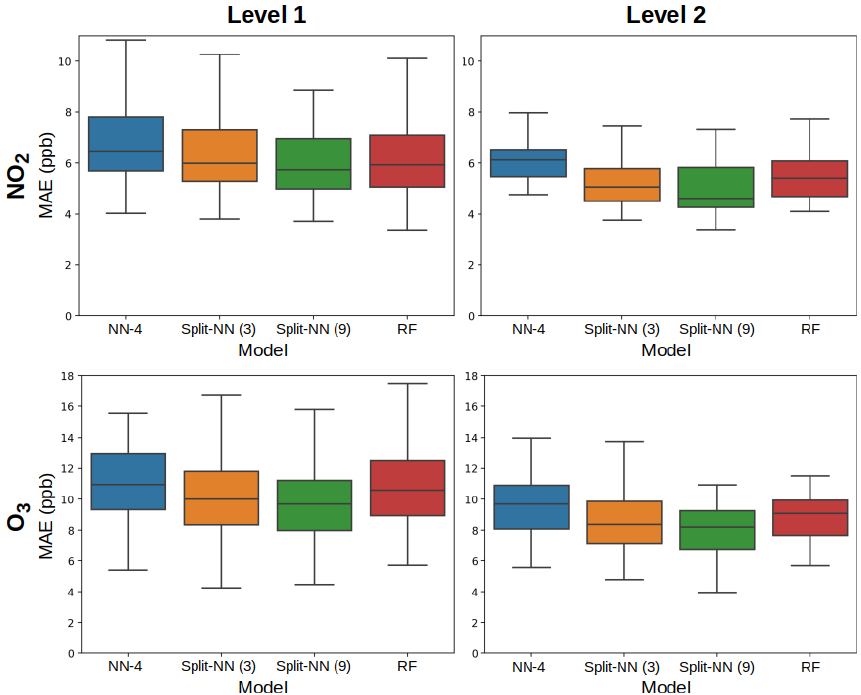
Figure 10. Results of evaluating the split-NN model with a linear regression first stage, compared against the RF model in both Level 1 and Level 2 comparisons. The split-NN model has a lower mean and median error in all conditions. Boxplots are pictured without outliers for